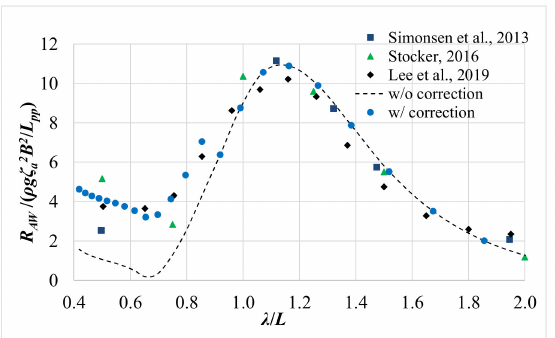
Figure 6. The comparison between numerically and experimentally obtained coefficients of added resistance in waves for KCS ship, data from [44–46].